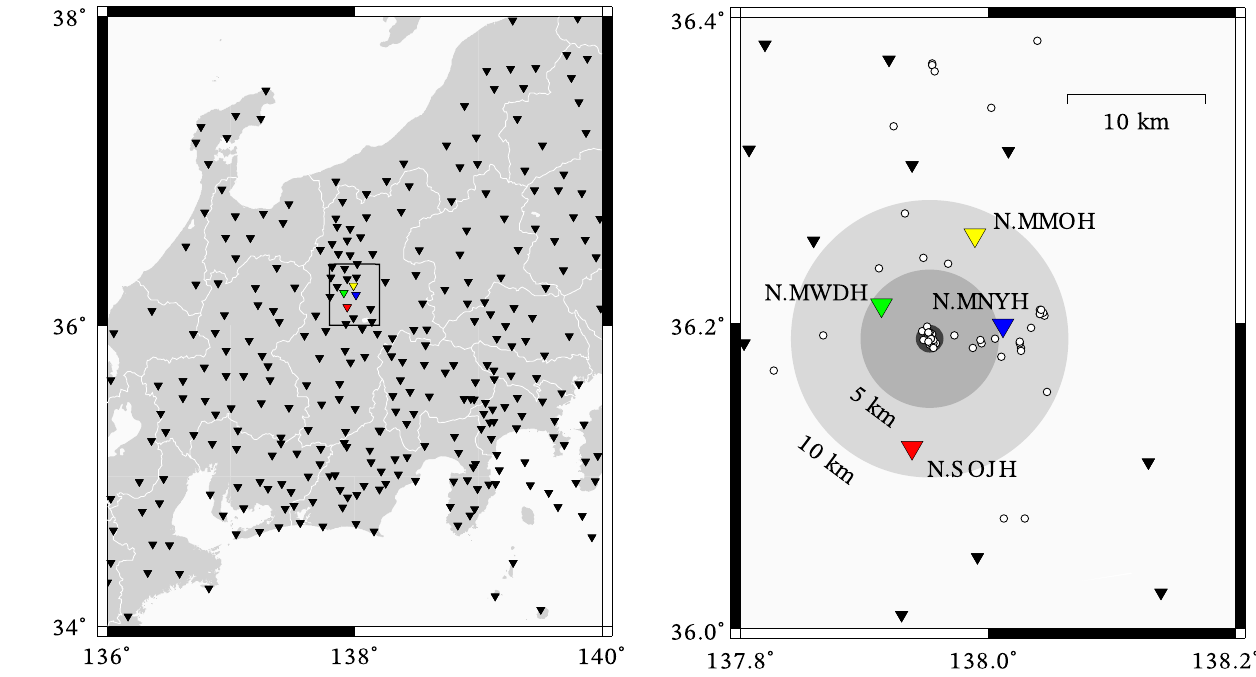
Figure 3. Distribution of observation points (triangles) and foreshock hypocentres (white circles) prior to an M5.4 mainshock in Nagano, Japan. Waveforms observed at N.MWDH (green), N.MNYH (blue), N.MMOH (yellow), and N.SOJH (red) stations were analyzed in this study. See Table S.1 for detail of the 27 events within 1 km from the epicenter shown in the darkest circle.